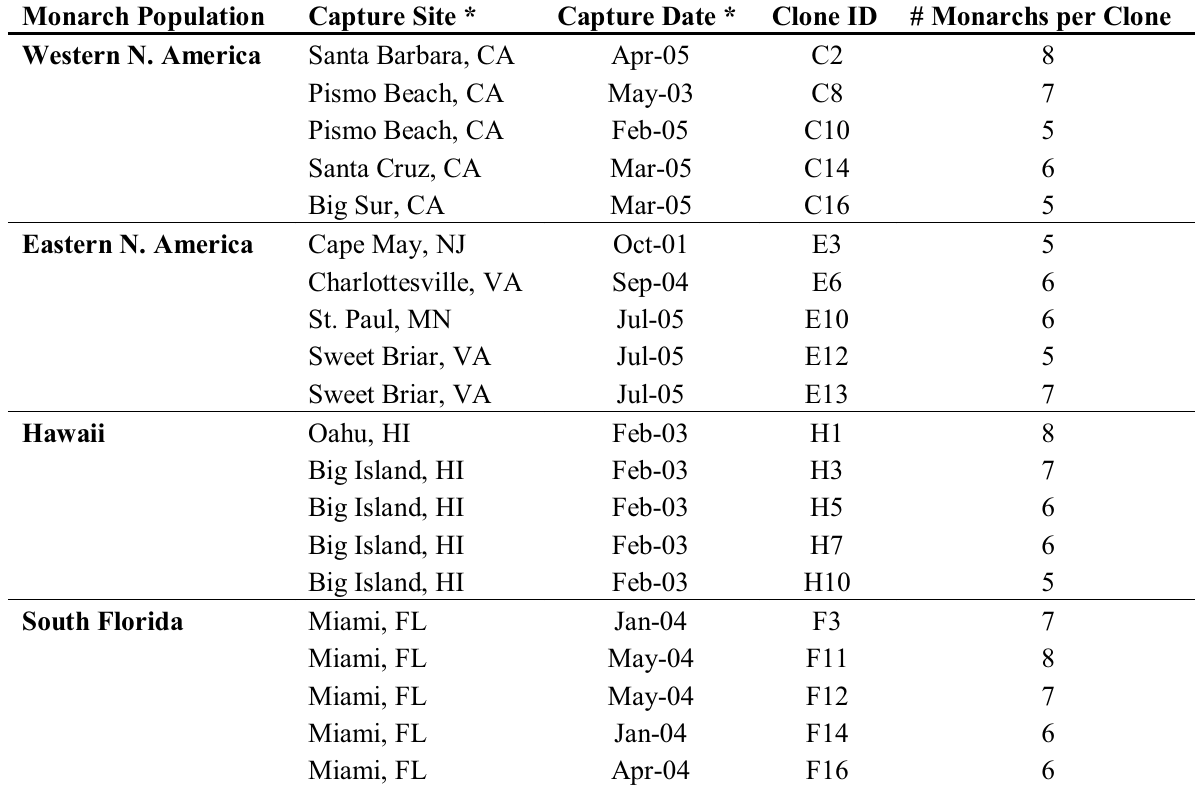
Table 1. Parasite sources, based on sites and dates of capture of infected butterflies, and number of infected monarchs from each clonal line of OE used in this study, including only hosts for which wing data were available (last column, n = 126